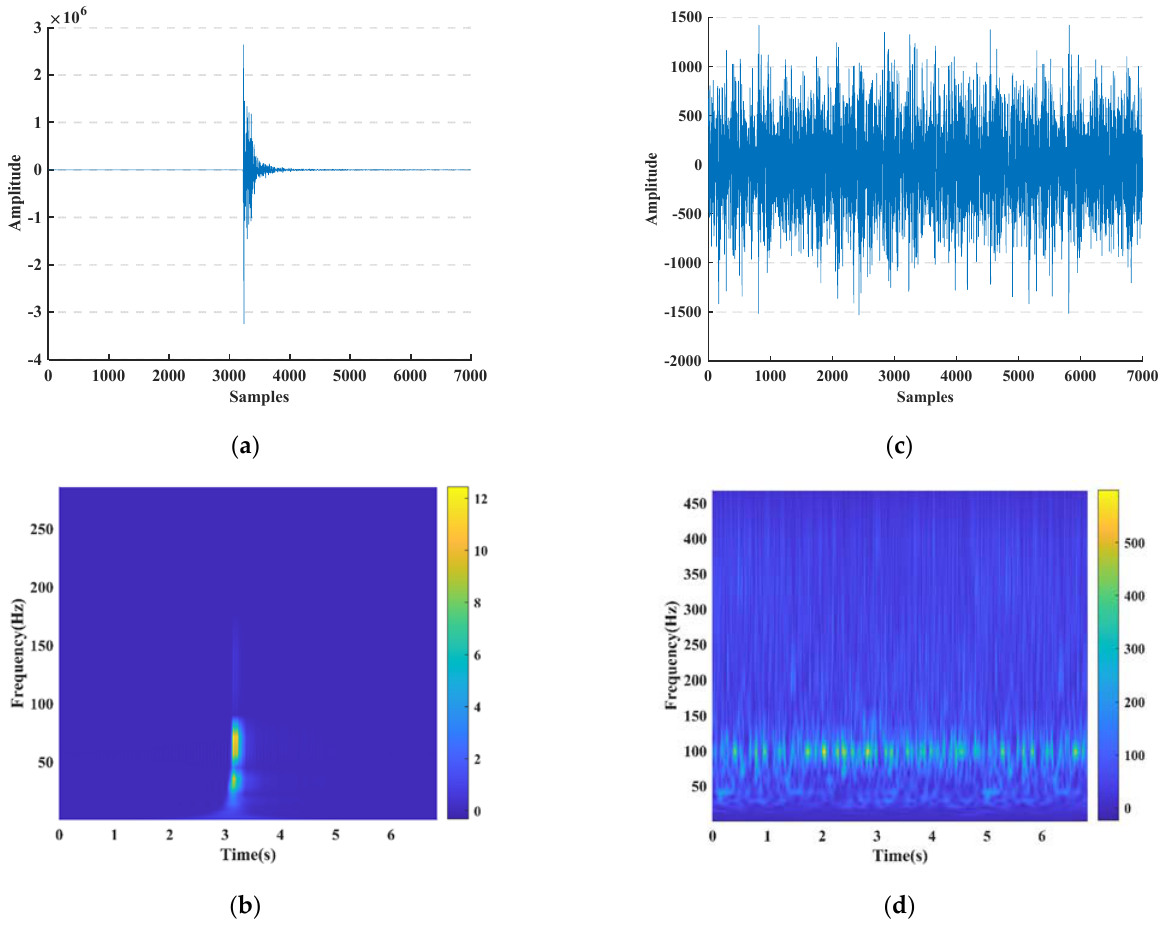
Figure 4. ( a ) microseismic signal, ( b ) scattergram time-frequency analysis of ( a ). ( c ) noise signal, ( d ) scattergram time-frequency analysis of ( c ).